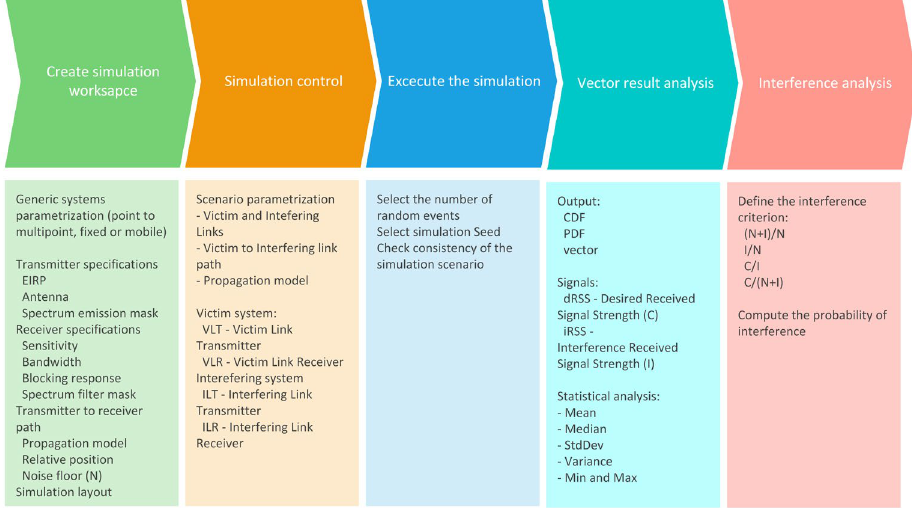
Figure 1. Simulation workflow in SEAMCAT.